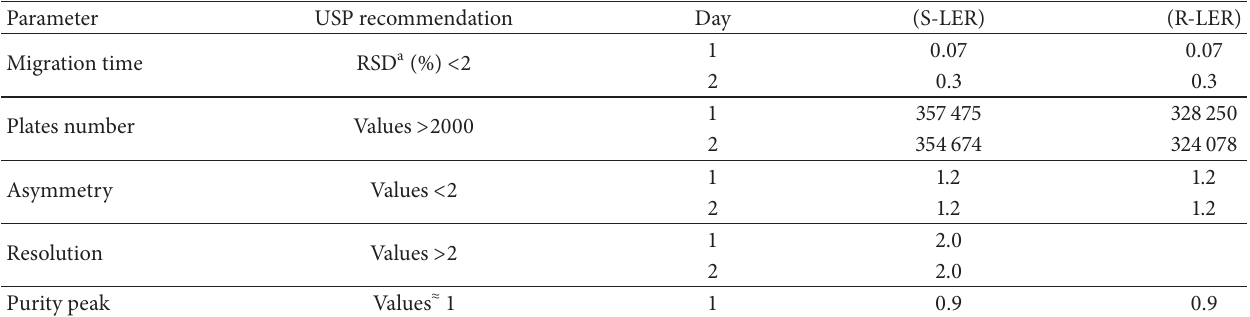
Table 4: Results of the system suitability test for LER enantiomer analysis.